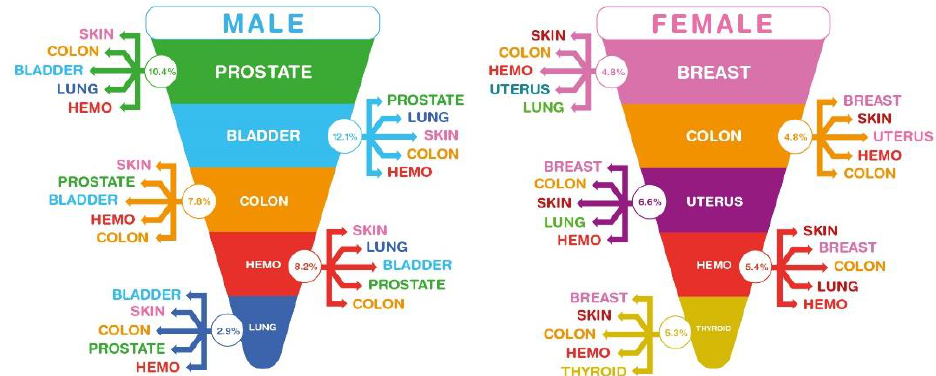
Figure 1. Second primary cancer sites, according to the site of the first primary cancer. FPCs are listed in white font and shown in decreasing order (the data can be found in Table S4 of the Supplementary Materials); percentages are shown of all SPCs, with the five most frequent sites listed in colored fonts, displayed in decreasing order from top to bottom (data in Table S5 of the Supplementary Materials).